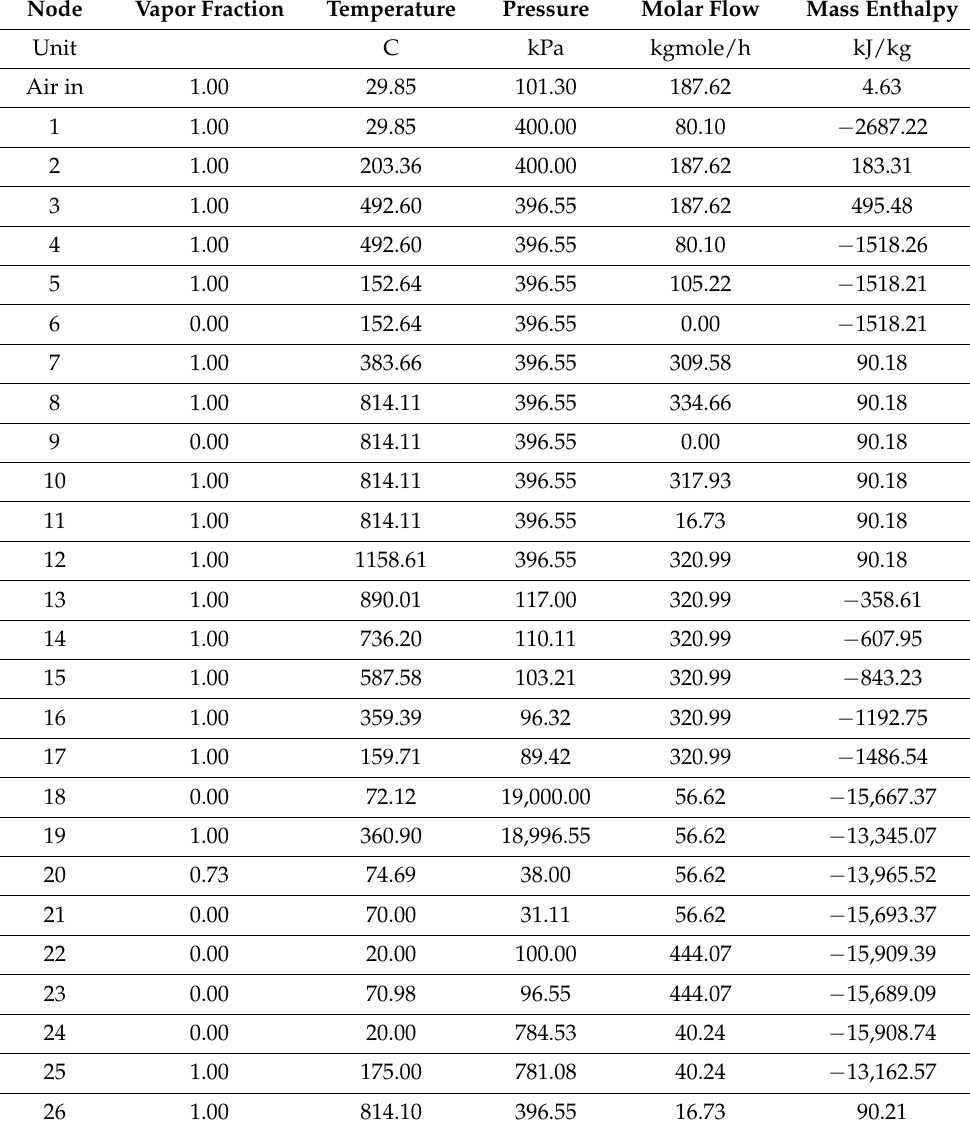
Table 4. Simulation results of integrated